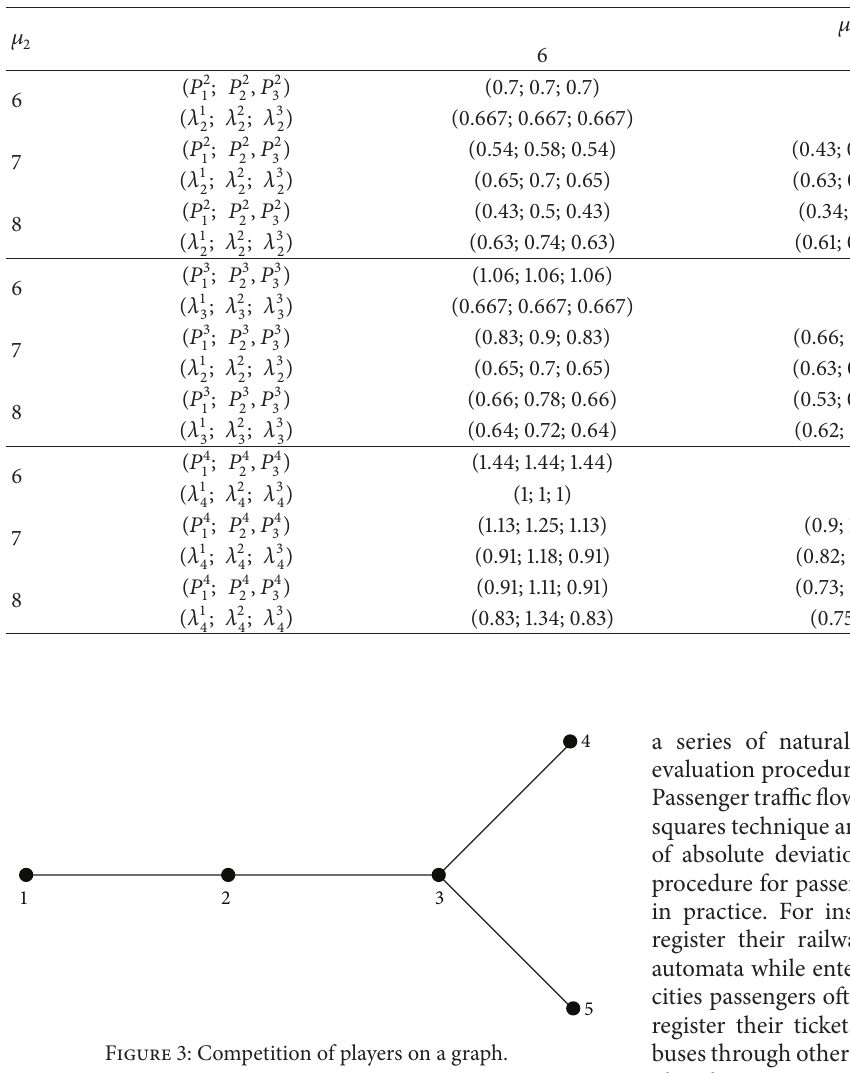
Table 9: The values (𝑃 𝑖 1 ,𝑃 𝑖 2 , 𝑃 𝑖 3 ) and (𝜆 1 𝑖 , 𝜆 2 𝑖 ,𝜆 3 𝑖 ) under 𝜆 2 = 2, 𝜆 3 = 2, 𝜆 4 = 3, 𝜆 5 = 3, and 𝜇 1 = 6; 𝑖 = 2, 3, 4.